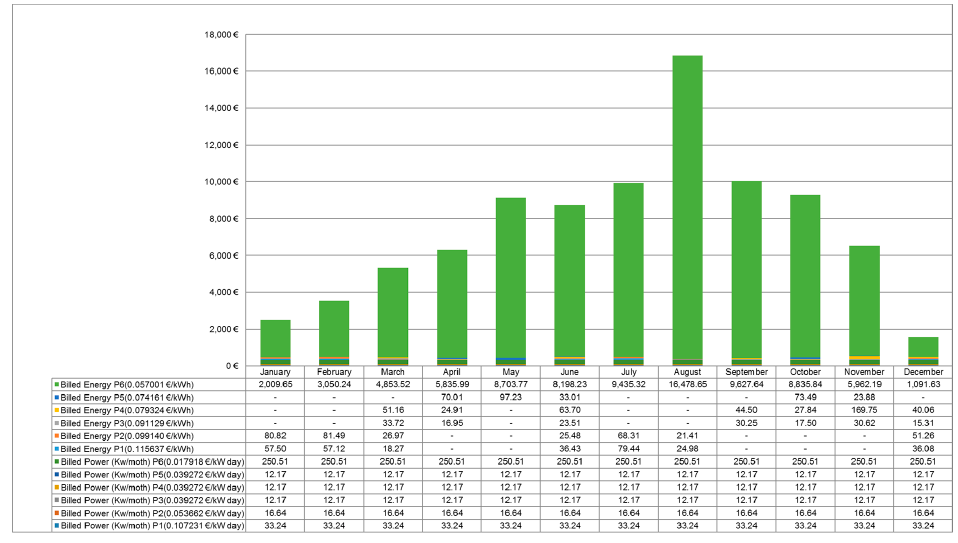
Figure 4. Financial expenses of the well.